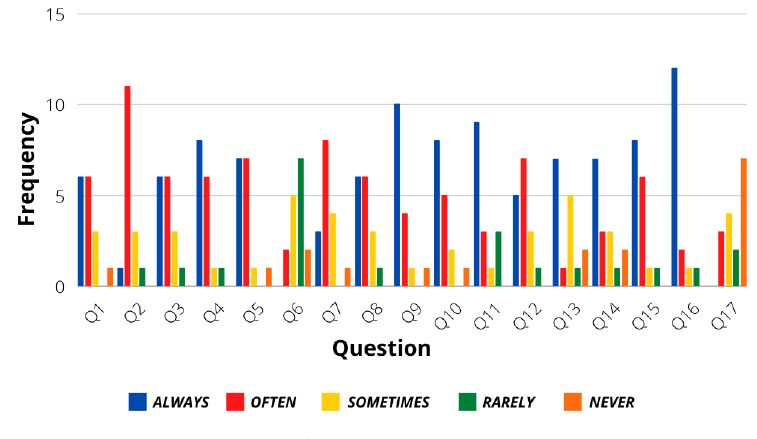
Figure 3. Questions 1–17 results.